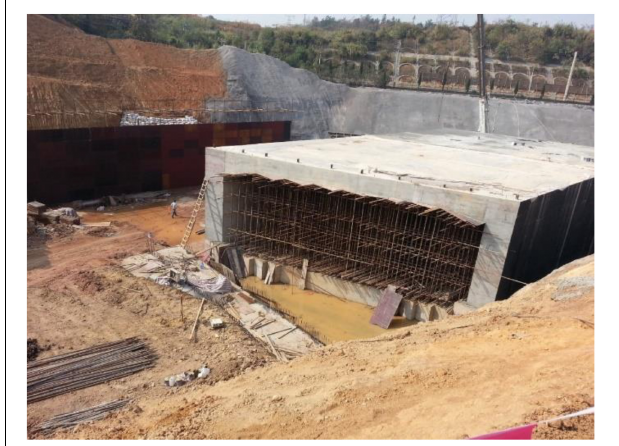
FIGURE 1 | A structure in the study area constructed on the red clays.